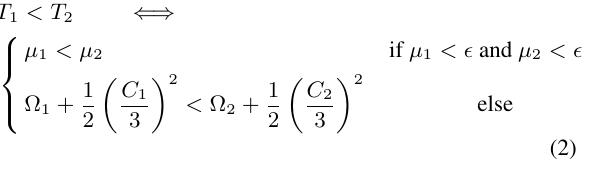
(g) Inter ray tracing based result.. (h) Self ray tracing based result. Figure 9. Inconsistent object detection exhibit two types of dy- namic object: (a),(e) is the reference mesh, (b),(c),(d) is a mov- ing person, (f),(g),(h) is a shortly standing person. Color code: Inconsistent , single and triangles behind inconsistent in